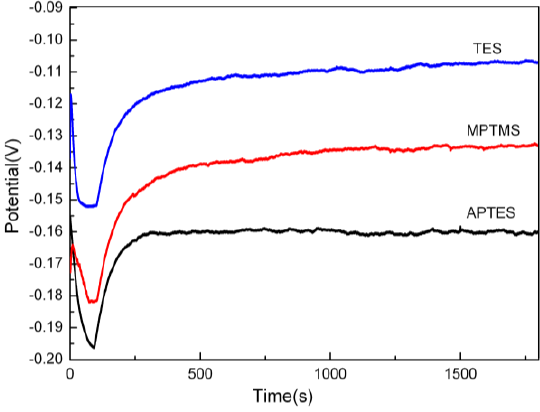
Figure 1. Potential curves of copper electroplating on different SAMs modified